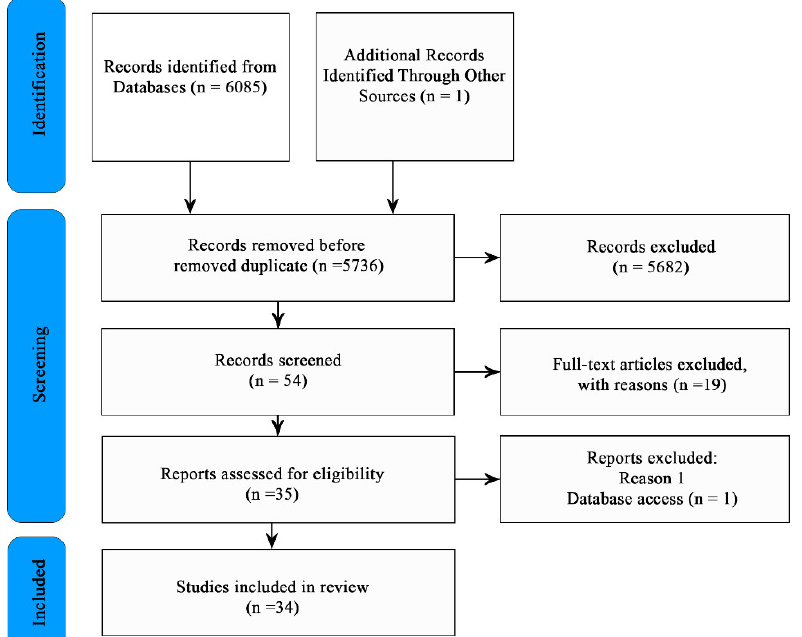
Figure 1. Process of search, selection and identification of studies according to the Preferred Reporting Items for Systematic Reviews and Meta-Analyses (PRISMA) 2020 flow diagram for new systematic reviews, which included searches of databases, registers and other sources [16].